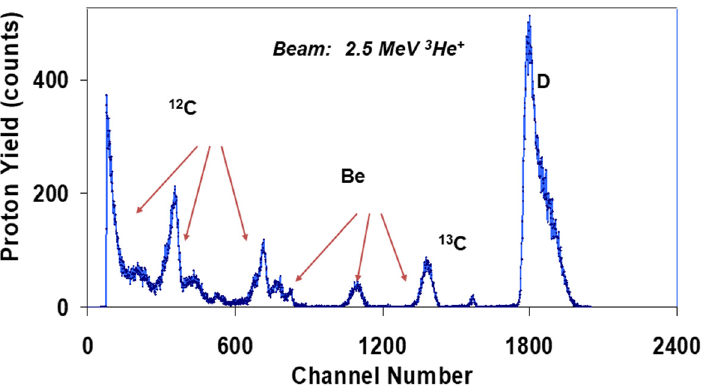
Figure 4. 3 He-NRA spectrum for a divertor tile from JET-C showing features of carbon ( 12 C and 13 C), Be and D.